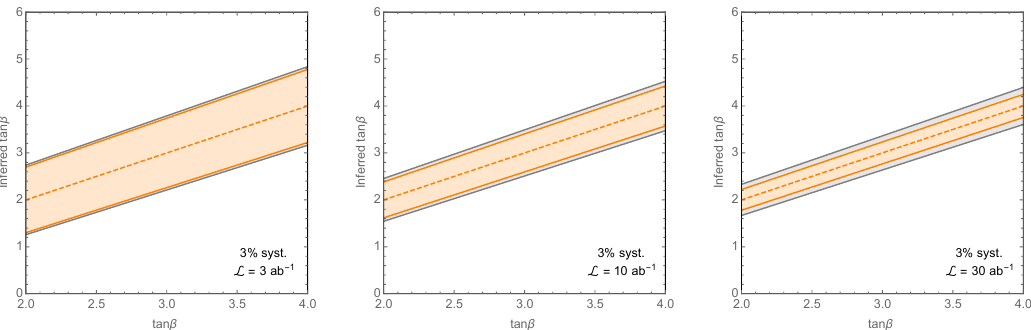
Figure 12 . Inference of tan (cid:12) from the measurement of e H 0 ! Z e B decays. The parameters are M 3 = 2 TeV, M 1 = 200 GeV, M 2 = 800 GeV, (cid:22) = 400 GeV. The orange shaded band represents 1 (cid:27) statistical uncertainty and the gray region additionally includes a 3% systematic